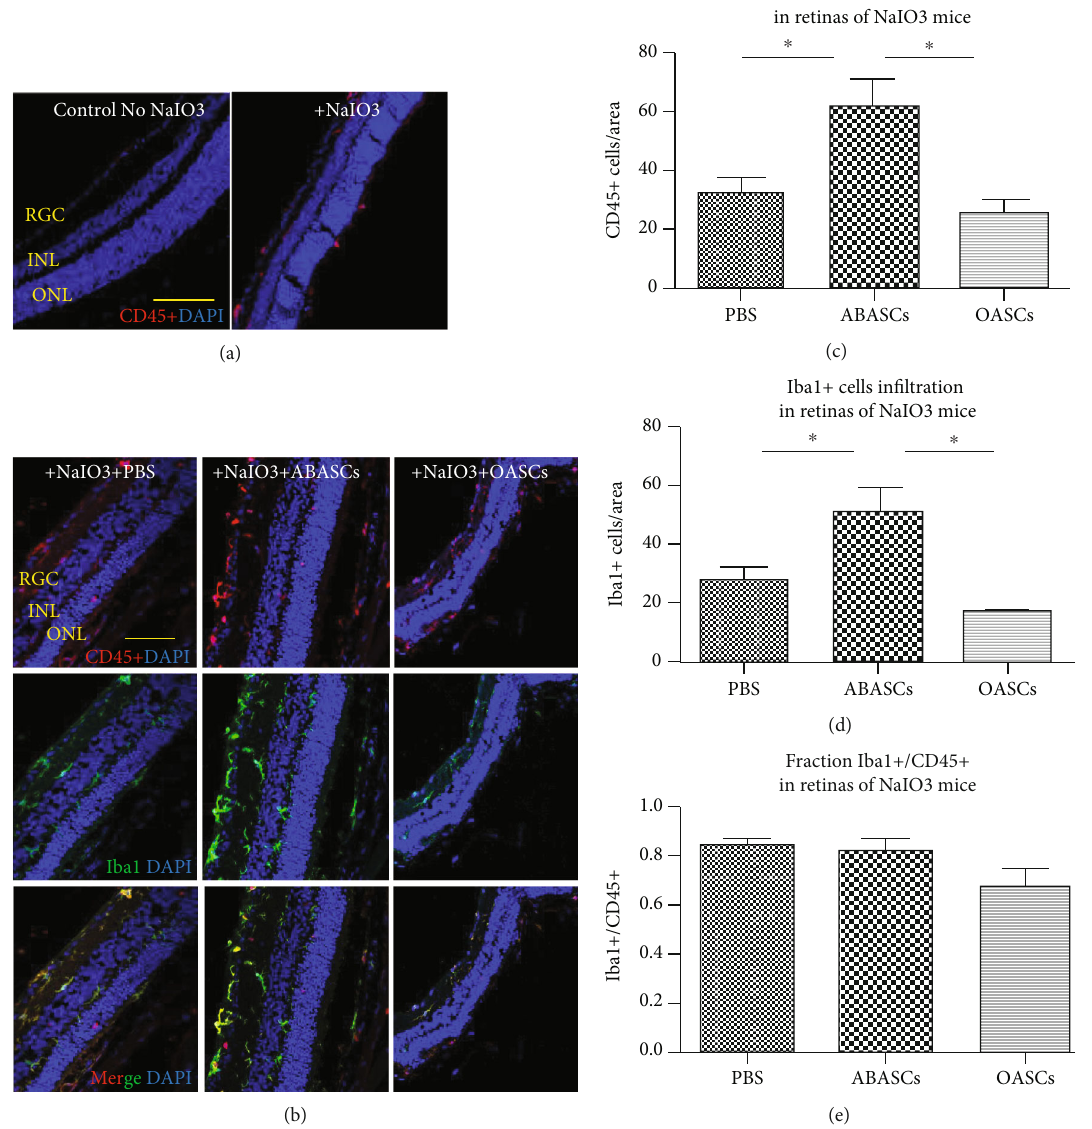
Figure 6: Immune response 21 days post transplantation of ABASCs and OASCs in the NaIO3 mice model. (a) Immunohistochemistry pictures of CD45+ staining in NaIO3-treated mice compared to nontreated mice revealed the in fi ltration of CD45+ cells in the retinas of NaIO3-treated mice compared to controls. (b) Immunohistochemistry pictures of CD45-Iba1 costaining. (b, c) Quanti fi cation of the number of CD45+ cells revealed a higher in fi ltration of leucocytes in ABASC-treated mice compared to PBS treated mice ( p ≤ 0 : 05 ). (b) – (d) Quanti fi cation of the number of Iba1+ cells revealed a higher in fi ltration of Iba1+ cells in ABASC-treated mice compared to OASC-treated mice and to PBS-treated mice ( p ≤ 0 : 05 ). (b) – (e) Most of CD45+ cells expressed Iba1 in all treated groups. ONL: outer nuclear layer; INL: inner nuclear layer; RGC: retinal ganglion layer. Bar = 50 μ m . For each group of mice, n = 5 . Data are represented as mean ± SEM